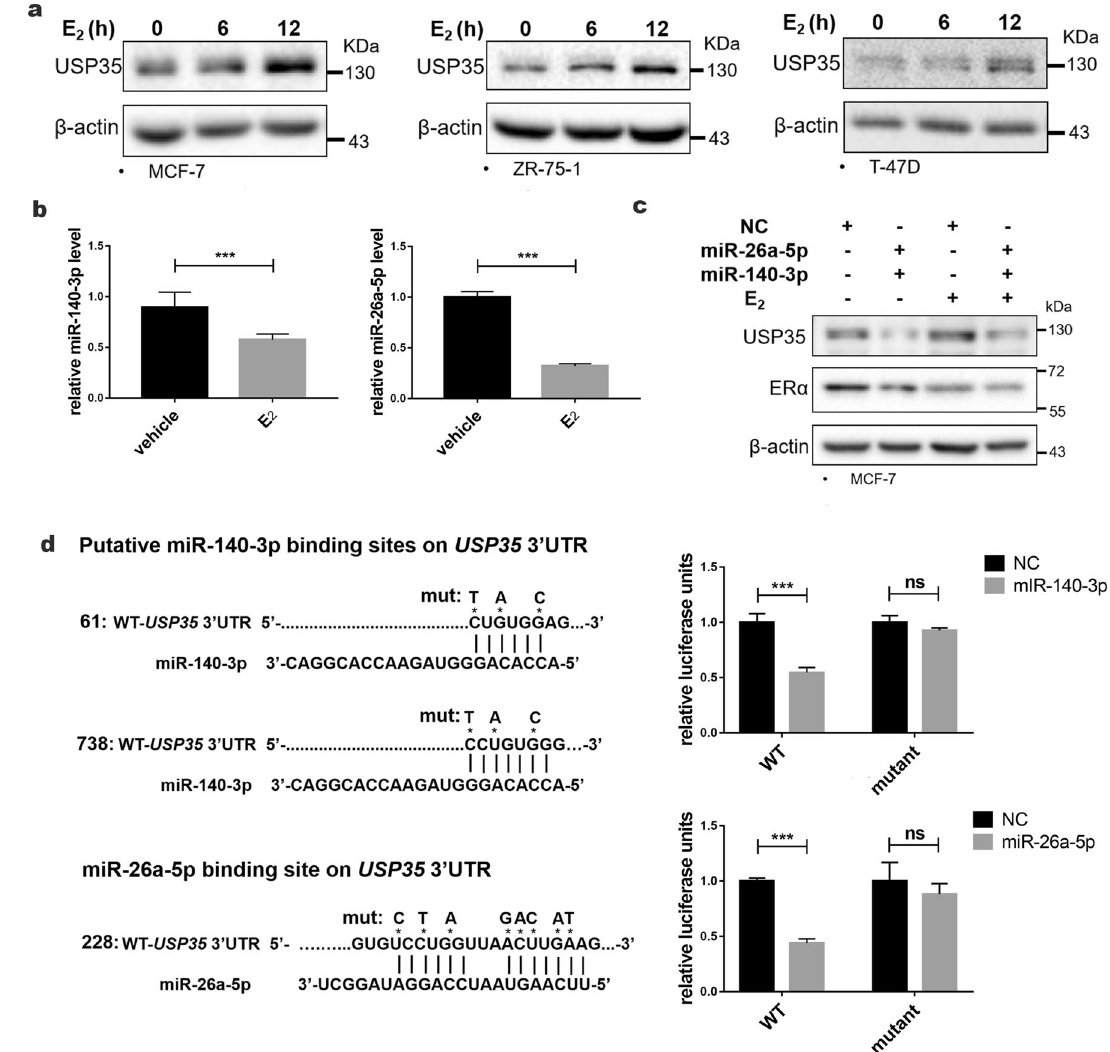
miR-26a-5p and miR-140-3p levels. MCF-7 cells were treated with vehicle or E 2 (10nM) and subjected to qRT-PCR analysis. ***, p <0.001. c miR-140-3p and miR-26a-5p can reduce E 2 -enhanced USP35 protein levels. MCF-7 cells were transfected with scramble negative control RNA (NC), the indicated miRNA mimics, respectively, and treated with E 2 for 24h before being subjected to immunoblotting. d USP35 3 ′ UTR contains the predicted miR-140- 3p target sites in positions 61 – 66 and 738 – 744 (top left) and miR-26a-5p target site in position 228 – 234 (bottom left). MCF-7 cells were co-transfected with NC, miR-140-3p, or miR-26a-5p mimics respectively, together with USP35 -3 ′ UTR-WT-luc or USP35 -3 ′ UTR-mut-luc plasmids. The top and bottom right panels contain the USP35 -3 ′ UTR-mut-luc plasmids in which the miR-140-3p and miR-26a-5p target sites were mutated respectively. The normalized relative luciferase activities were shown on the right panels. ns not signi fi cant; ***, p